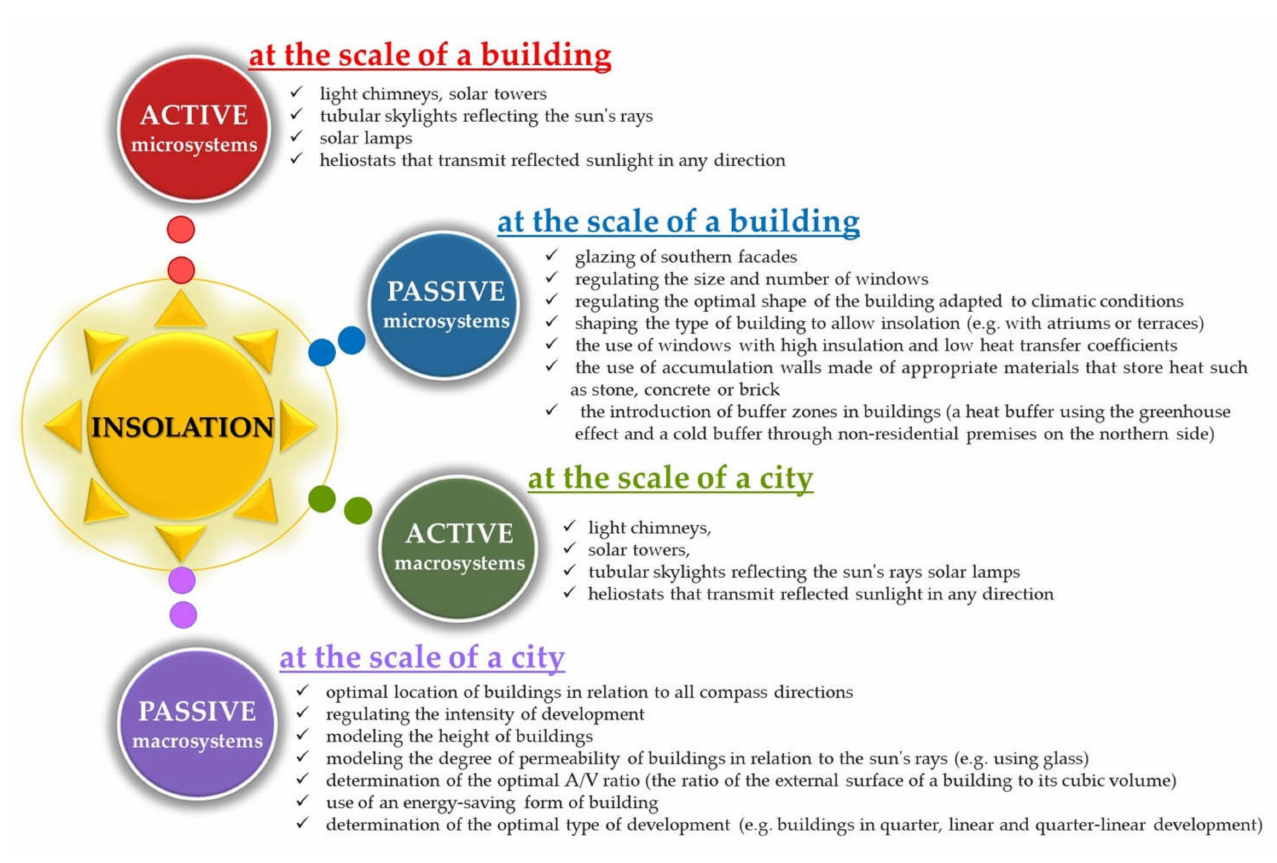
Figure 3. Multi-scale systems of passive and active insolation on micro- and macroscales (authors).